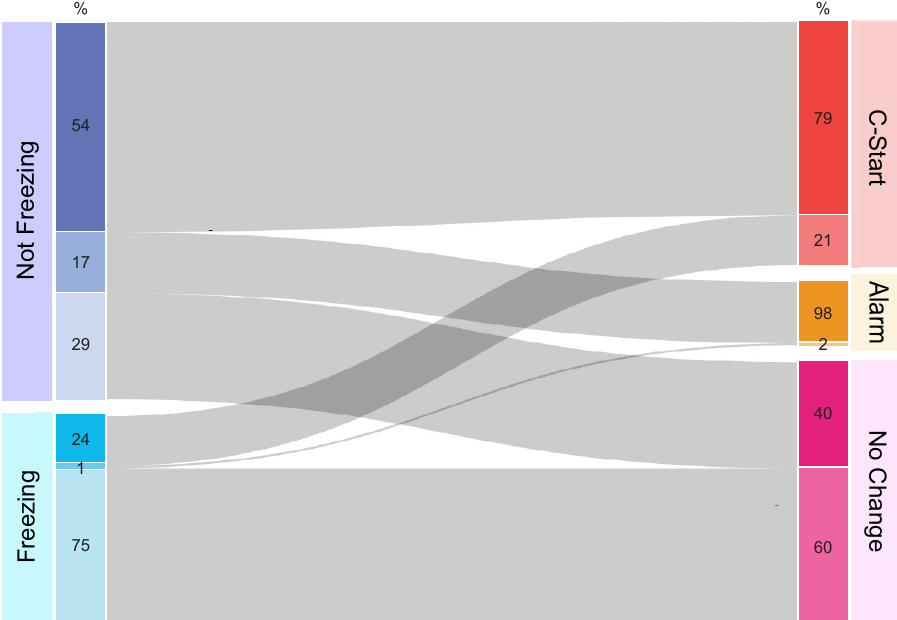
Figure 2. Risk assessment is affected by prior motor state. Alluvial diagram of fish motor behavior in each trial before and after stimulation. The diagram shows the motor state before (Not Freezing, n = 1003, N = 156 or Freezing, n = 580, N = 121) and after sensory stimulation (C-start, n = 675, N = 164; Alarm, n = 176, N = 98; No change in motor behavior, n = 732, N = 166) combining all stimulus conditions. Each motor state is further divided by its “future” or “past” action (numbers within colored boxes). For example, 54% of non-freezing animals executed a C-start, while 60% of animals that did not changed their motor behavior were freezing before